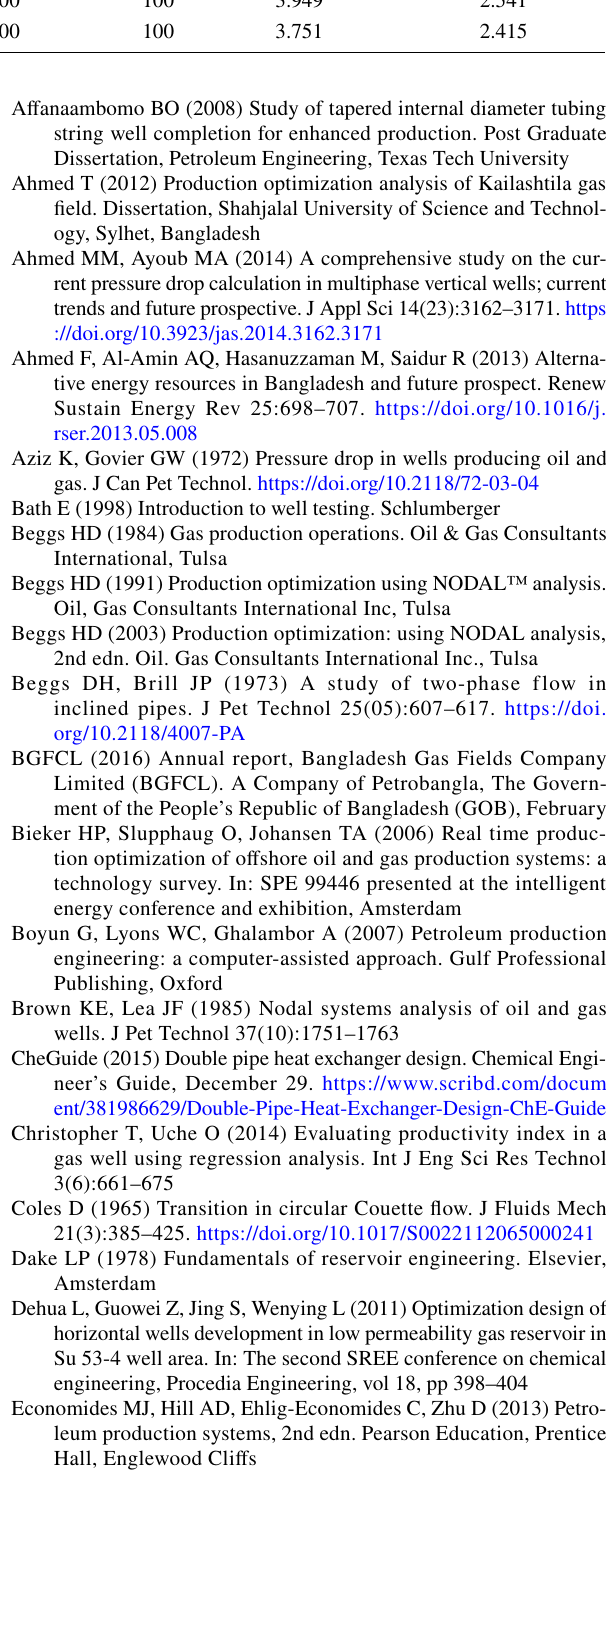
Table 6 Optimized liquid lift ratio of the HBJ-06